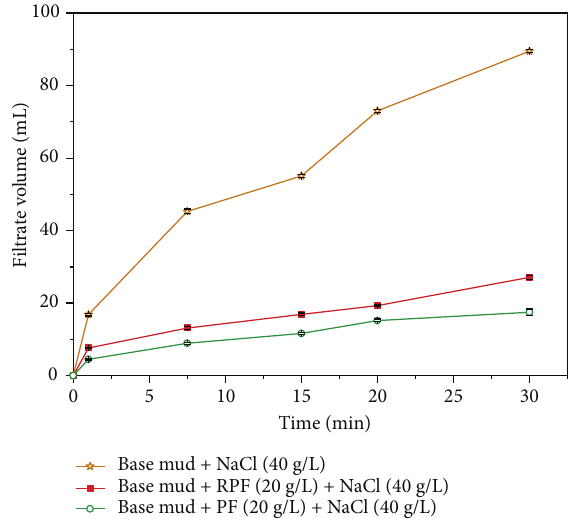
Figure 10: API filtration loss of RPF and PF in base mud and NaCl (40g/L) solutions.